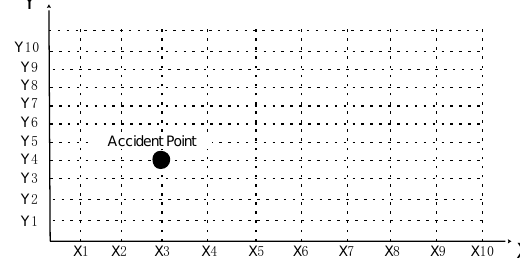
Figure 3. Accident descriptive model.